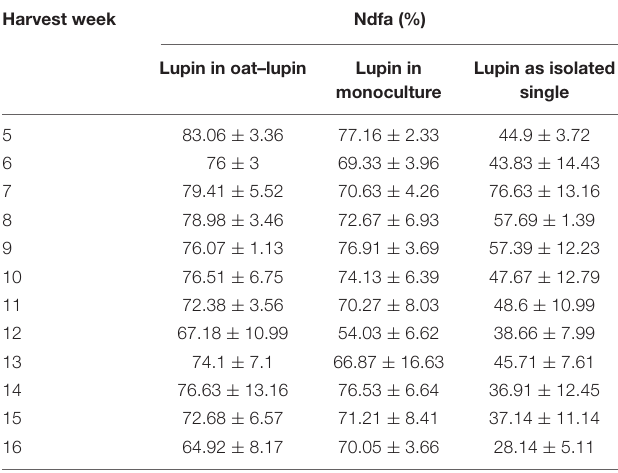
TABLE 2 | Mean nitrogen derived from the atmosphere (Ndfa)[%] ± SE ( n = 3) per harvest week for lupin grown in mixture, in monoculture and as isolated single plant.